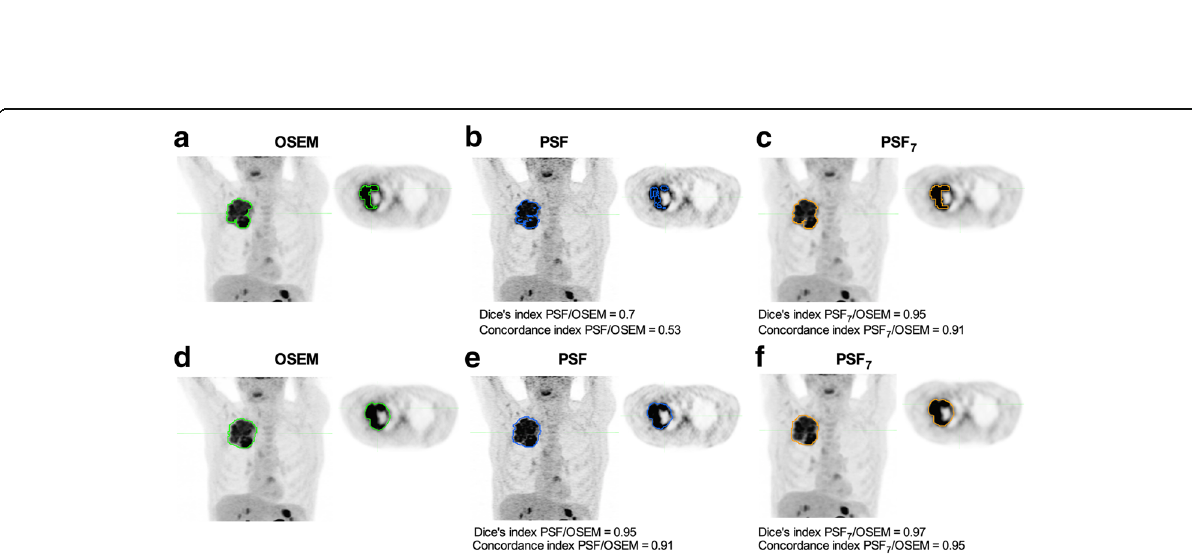
Fig. 5 Impact of the EARL harmonization strategy on Dice and concordance indices between MATVs extracted from OSEM images and PSF images (observer 1). The PSF 7 images were filtered to meet EARL requirements while PSF images were optimised for diagnostic potential. Data are shown as Tukey boxplots ( lines displaying the median, 25th, and 75th percentiles; crosses represents the mean values). Dice coefficients and concordance indices are shown for both the isocontour-based method ( a , b ) and gradient-based method ( c , d ). ns not significant